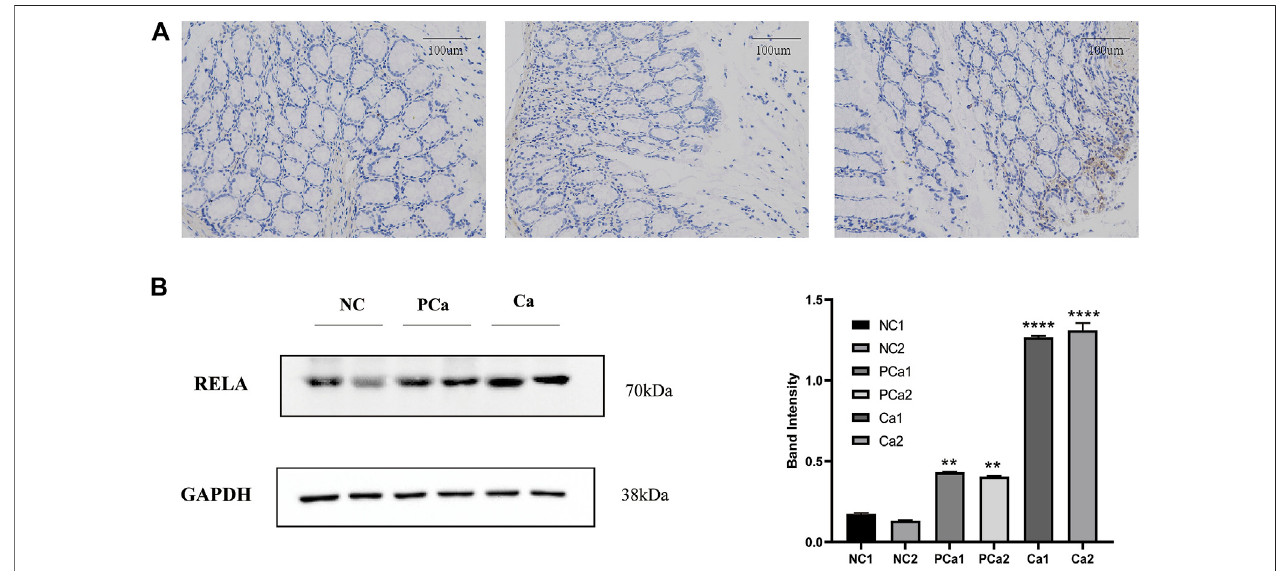
FIGURE 7 | The RELA molecule was highly expressed in human colorectal cancer tissue samples. (A) Images depicting immunohistochemical (IHC) staining of RelA conducted in tissue sections derived from human normal colon, paracarcinoma tissues, and colon cancer samples. Images were captured at × 200 magni fi cation. (B) Westernblotand gray valuestatisticsofRelA inhumancolontissuesamples.NC,normalcolonofthepatient; PCa,paracarcinoma tissues ofthepatient; Ca,patient colon cancer tissue. * p < 0.05 vs. negative control (NC) group, ** p < 0.02 vs. NC group, *** p < 0.01 vs. NC group, **** p < 0.001 vs. NC